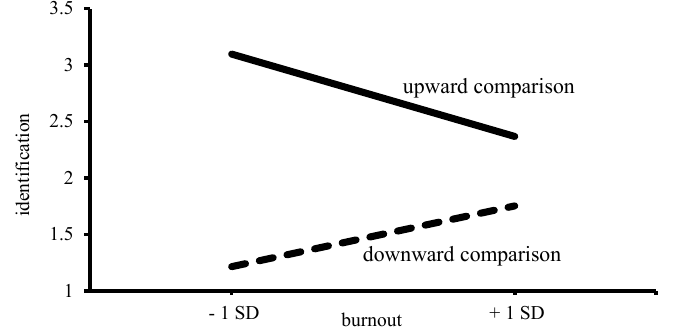
Figure 5. Identification as a function of burnout and comparison direction [13].